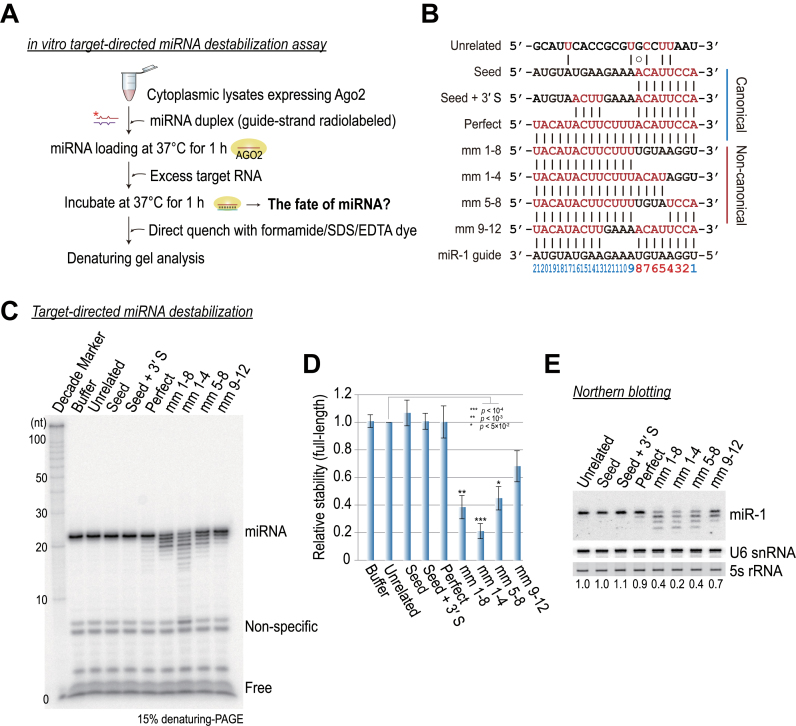

in vitro recapitulation of target RNA-directed miRNA destabilization in human Ago2. (A) A schematic illustration of the in vitro assay for target-directed miRNA destabilization. The asterisk indicates a 5΄-32P radiolabel. (B) Schematic of paired miRNAs and complement target RNAs. Targets lacking the canonical perfect seed match are considered to be non-canonical. (C) Non-canonical targets destabilize miRNAs in Ago2–RISC. (D) Quantitation of (C). The means ± standard deviations (SDs) for four independent replicate experiments are shown. The P-value was calculated with a Student's t-test. (E) Northern hybridization, which was performed with samples as described (A), but used cold miRNA duplexes. The blot was probed for U6 snRNA as a loading control. Ethidium bromide-stained 5S rRNA served as another loading control. The numbers below the blot are the relative expression levels, normalized using the U6 snRNA control.